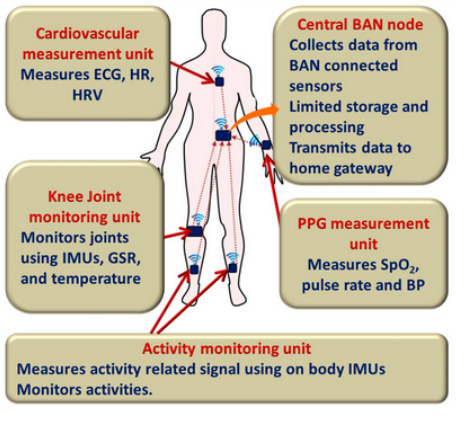
Figure 9. Different body sensor types.